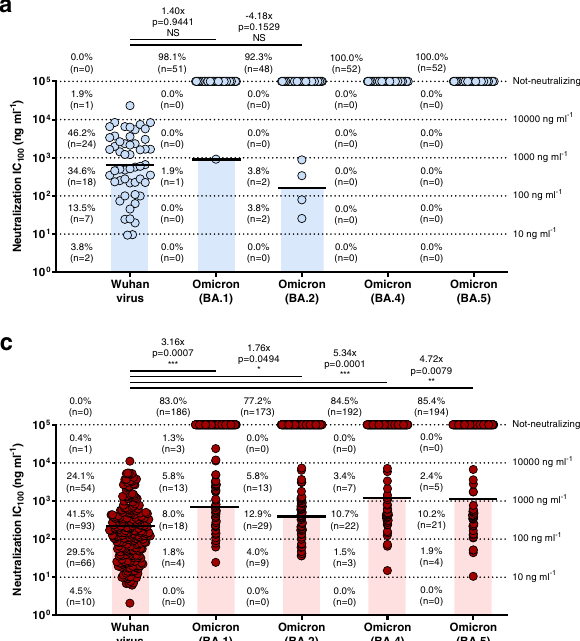
Fig. 1 | Potency and breadth of neutralization of nAbs against SARS-CoV-2 Omicronvariants. Scatterdotchartsshowtheneutralizationpotency,reportedas IC 100 (ngml − 1 ),ofnAbstestedagainsttheoriginalWuhanSARS-CoV-2virus,andthe Omicron BA.1, BA.2, BA.4 and BA.5 lineages for SN2 ( a ), SN3 ( b ), and SP2 ( c ), respectively. The number, percentage, GM-IC 100 (black lines and colored bars), fold-change and statistical signi fi cance of nAbs are denoted on each